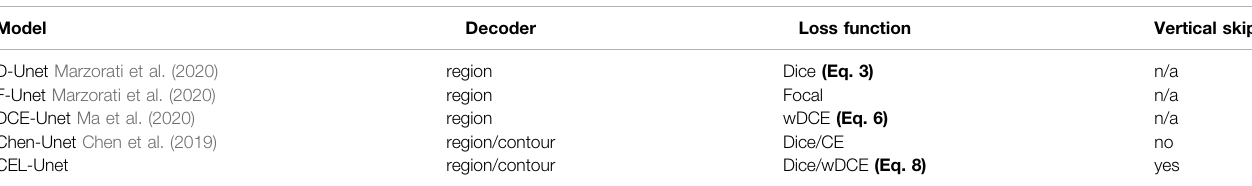
TABLE 4 | Comparison pf the proposed solution with literature Unet models and different loss functions. Model Decoder Loss function Vertical skip D-Unet Marzorati et al. (2020) region Dice (Eq.